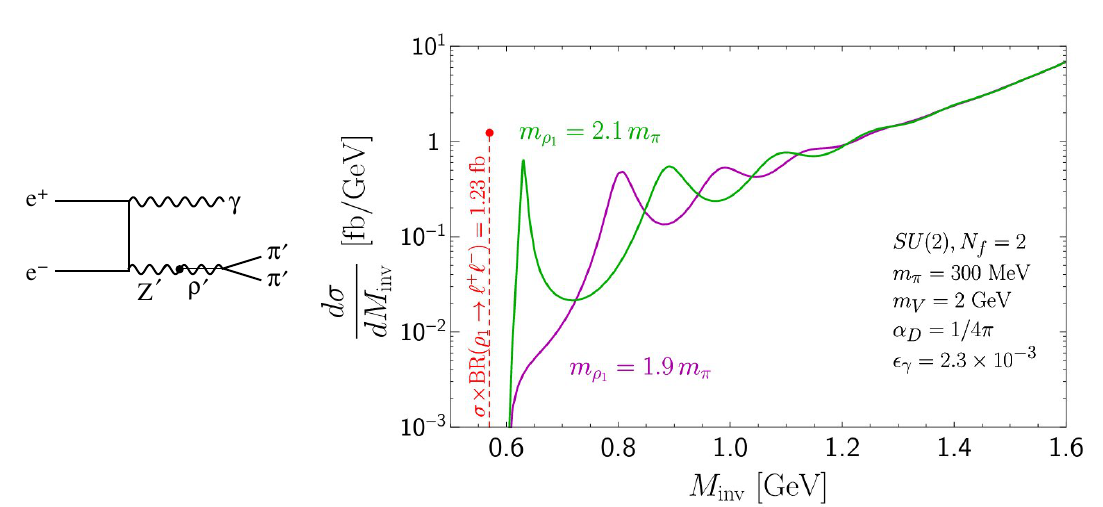
Figure 19: Left: diagram for producing a photon and invisible dark pions from e + e − scattering. Right: predicted spectrum for invisible invariant mass, from Ref. [ 117 ] .